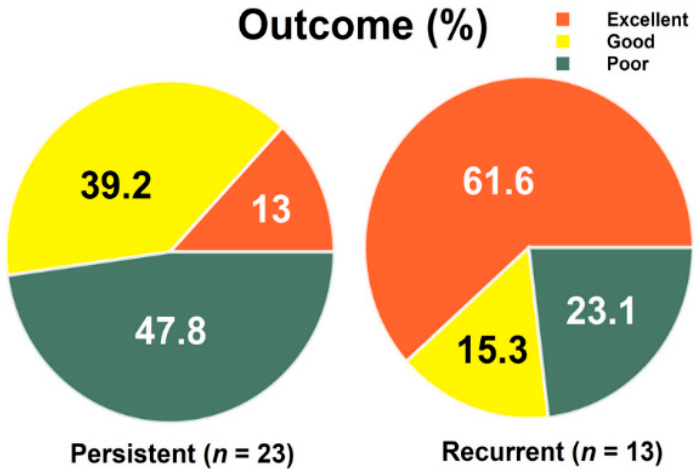
Figure 1. The percentage of outcomes among persistent and recurrent carpal tunnel syndrome. Re- current vs. persistent (Excellent outcome; 8/13 [61.6%] vs. 3/23 [13%], p = 0.006), two-way Fisher’s Exact